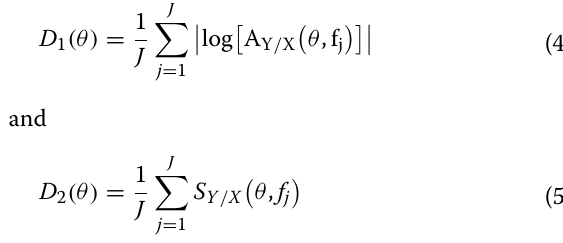
are introduced. D 1 represents the degree of dissimilarity between the two orthogonal components, and D 2 repre- sents the frequency average of the logarithmic standard deviation. The evaluated frequency range is f 1 f J 25 Hz, within which the S-coda wave is considered = to be composed of multiply scattered S-waves (e.g., Sato et al. 2012). D 1 is equal to zero if A Y / X is unity within the